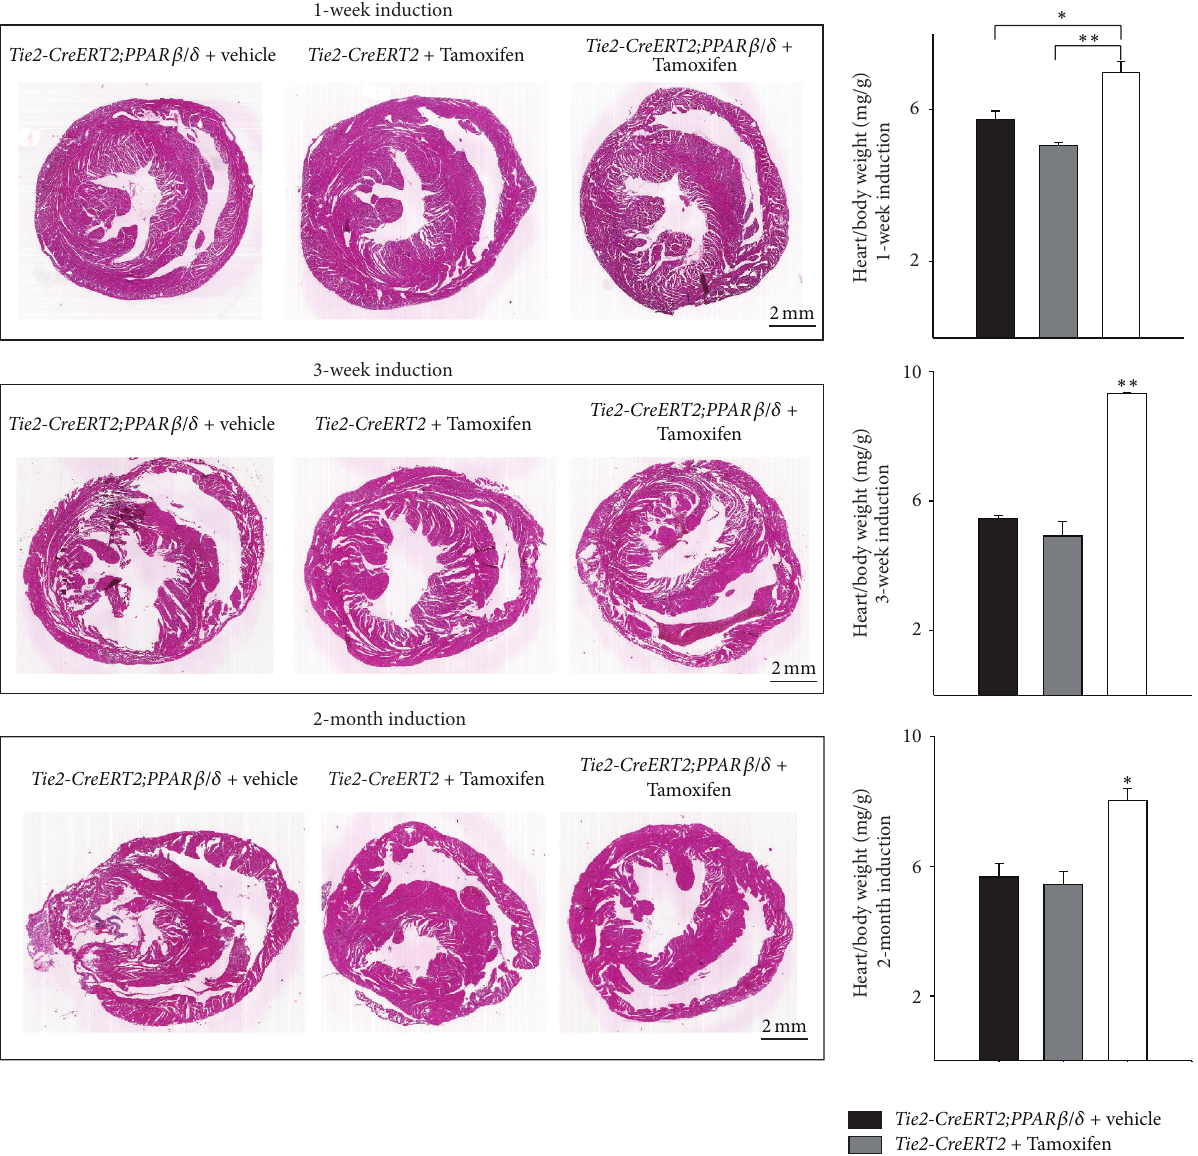
Figure2:RapidinductionofcardiacgrowthbyTie2-Cre-mediatedconditionalPPAR 𝛽 / 𝛿 overexpression.PhotomicrographsofHematoxylin- Eosin- (HE-) stained cross sections of the hearts and respective heart-to-body weight ratios ( Tie2-CreERT2;PPAR 𝛽 / 𝛿 + Tamoxifen, 𝑛 = 7 , Tie2-CreERT2;PPAR 𝛽 / 𝛿 + vehicle, 𝑛 = 6 , and Tie2-CreERT2 + Tamoxifen, 𝑛 = 6 ). Scale bars indicate 2 mm. Data are means ± SEM. ∗ 𝑝 < 0.05 and ∗∗ 𝑝 < 0.01